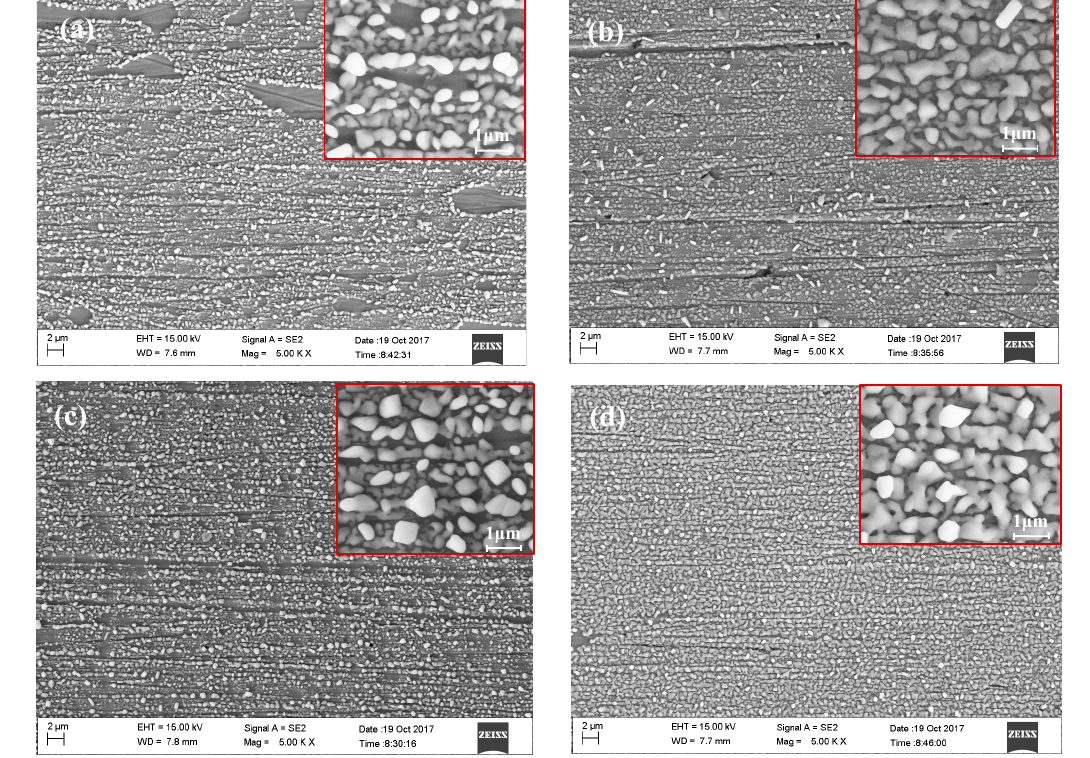
Figure 7. SEM, secondary electron image (SEI) of Sn electrodeposited at different deposition potentials: ( a ) − 0.45 V, ( b ) − 0.50 V, ( c ) − 0.55 V and ( d ) − 0.60 V. ( T = 323 K, c (SnCl2) = 0.2 M) (the upper right corner of the image is a 20,000× magnification image of the sample).